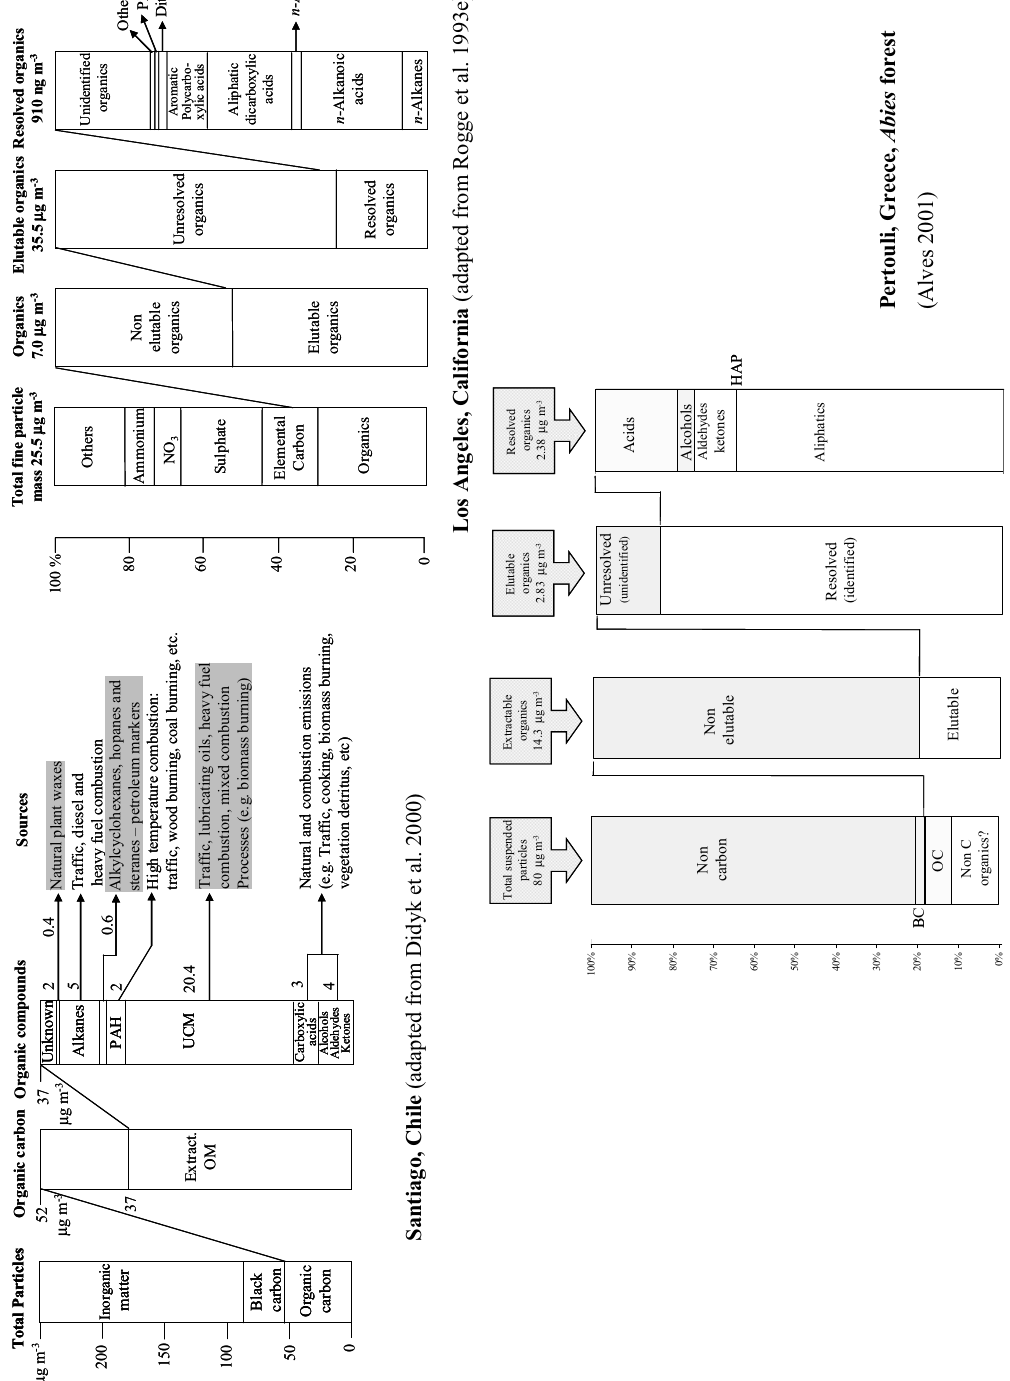
An Acad Bras Cienc (2008) 80